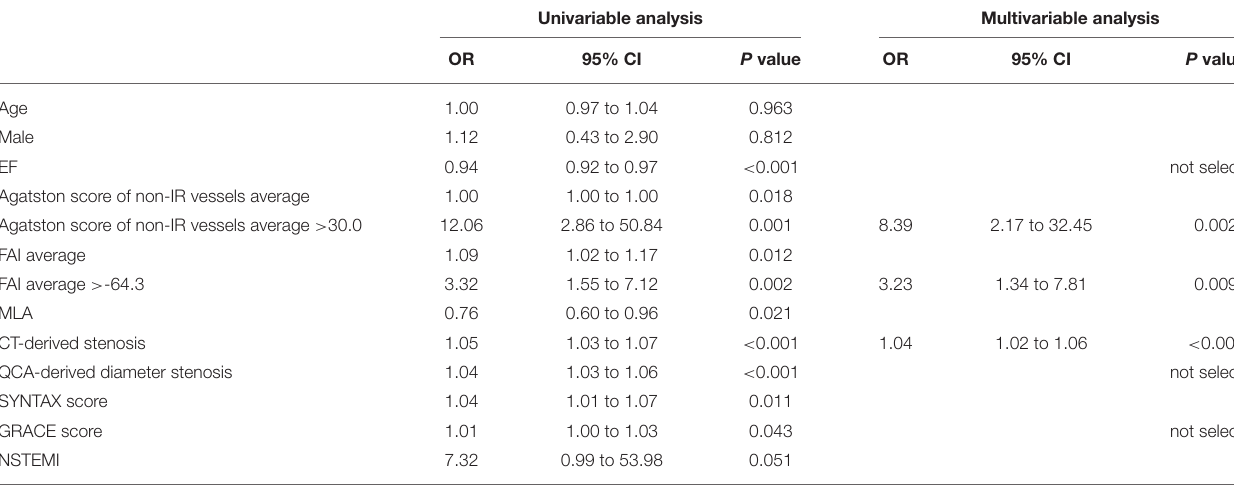
TABLE 3 | Univariable and multivariable logistic analysis of predicting non-IR UMI. Univariable analysis Multivariable analysis